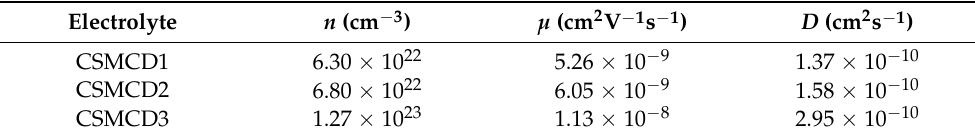
Table 4. The calculated transport parameters of the